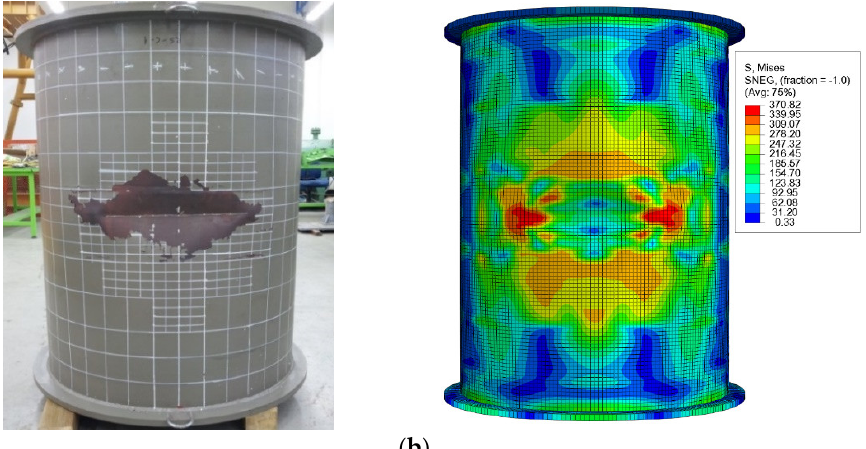
Figure 4. Comparisons of the test results with numerical predictions: ( a ) model SS-C-1; ( b ) model RS- C-1.